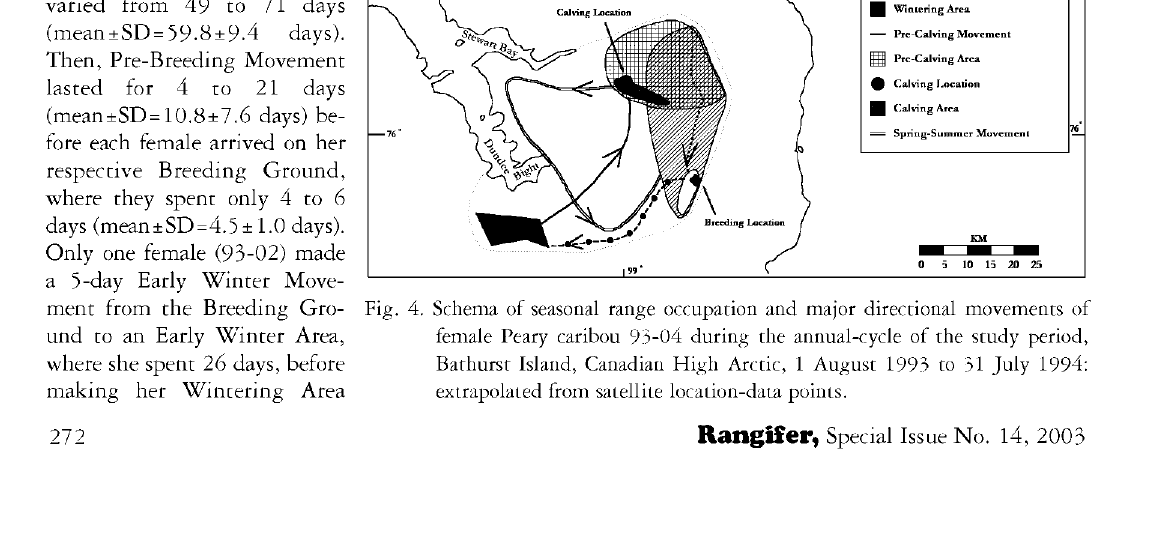
Fig. 4. Schema of seasonal range occupation and major directional movements of female Peary caribou 93-04 during the annual-cycle of the study period, Bathurst Island, Canadian High Arctic, 1 August 1993 to 31 July 1994: extrapolated from satellite location-data